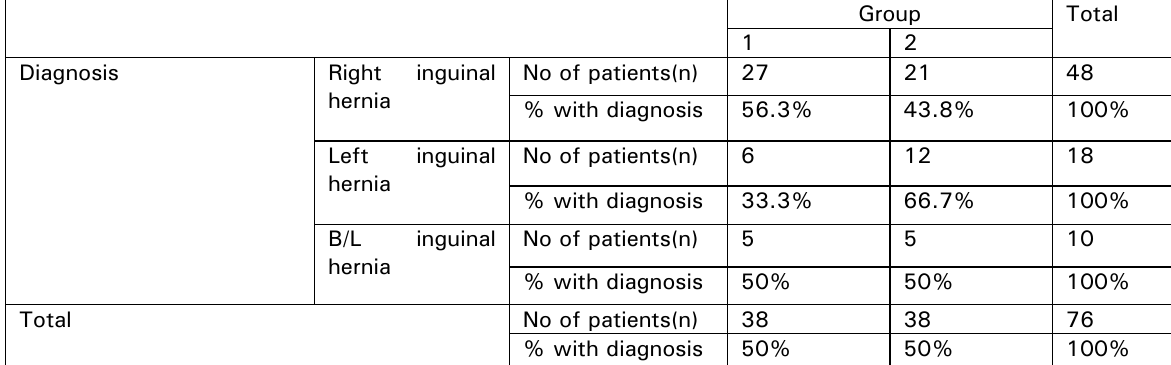
Table no 4. Distribution according to